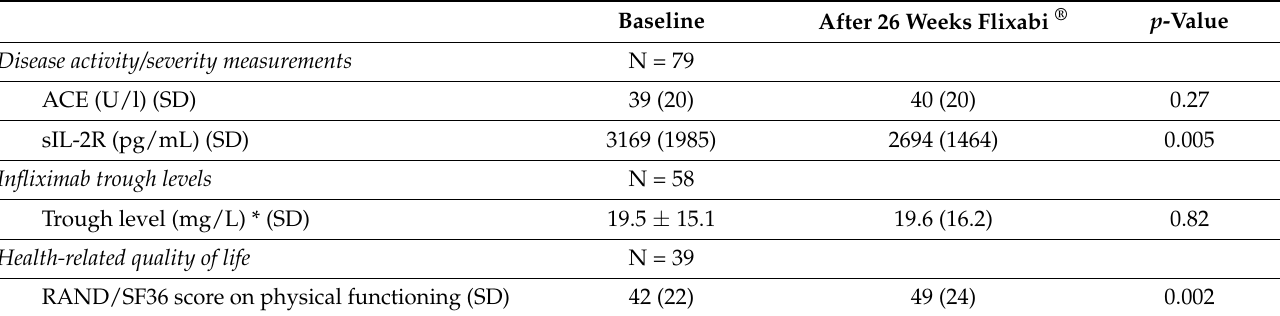
Table 3. Infliximab trough levels, disease activity, and health-related quality of life (physical functioning) at baseline and 26 weeks after switching to Flixabi ® treatment; Mean (SD).